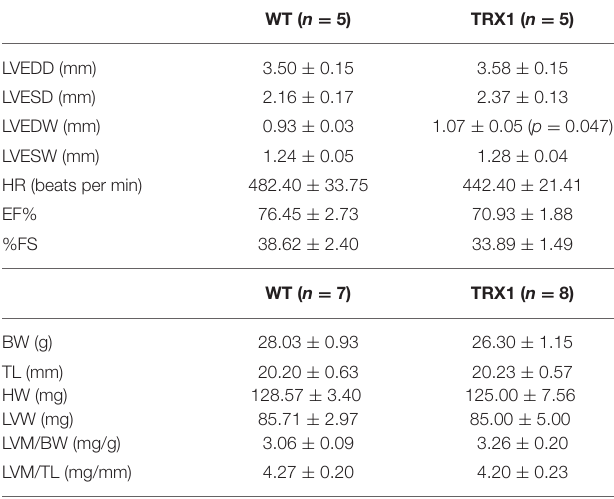
TABLE 1 | Echocardiographic and postmortem cardiac